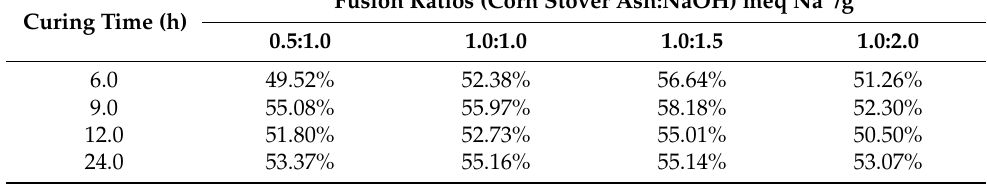
Table 2. Percentage of crystallinity (%CXRD) of zeolite A synthesized using various curing times and fusion